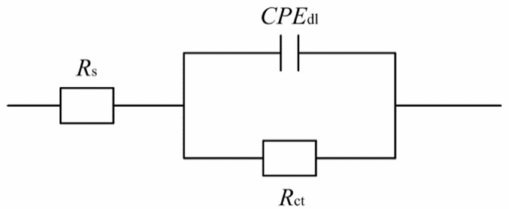
Figure 11. E ff ect of jet voltage on electrochemical impedance spectra of Ni–Co–P alloy coatings in artificial seawater: ( a ) Nyquist plots; ( b ) Bode plots.